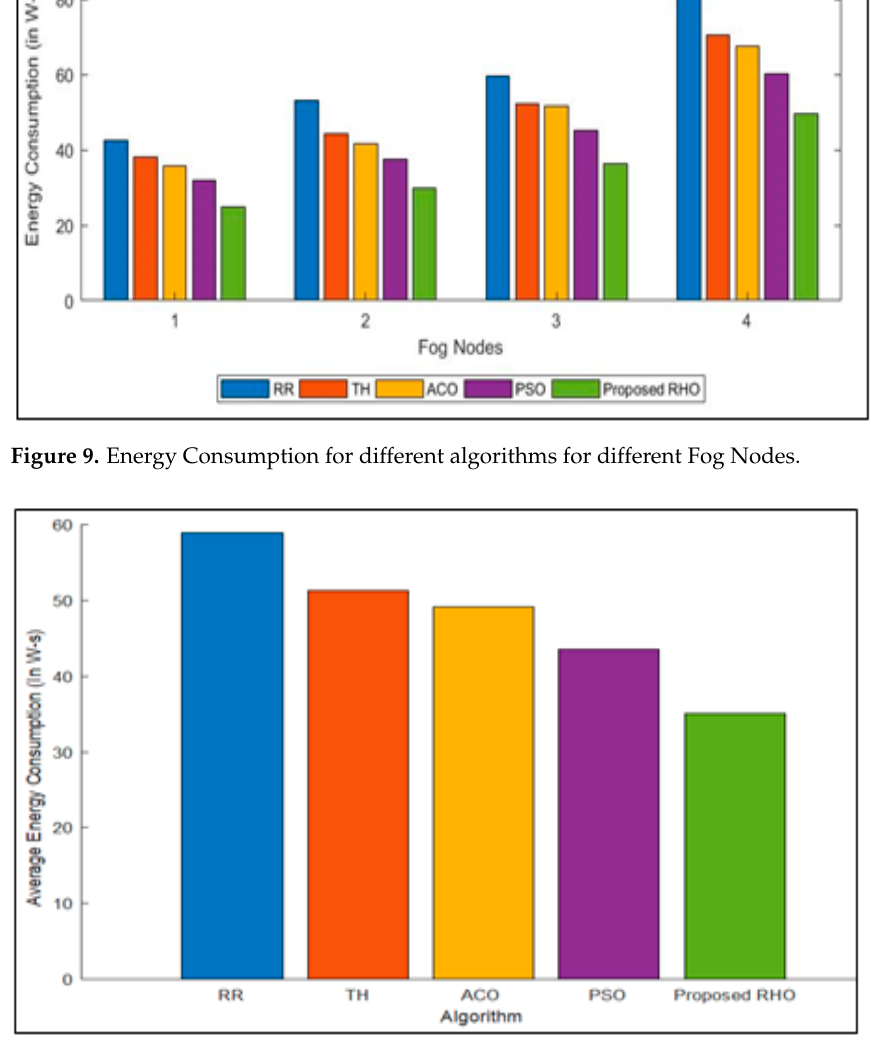
Figure 10. Average Energy Consumption for different algorithms.